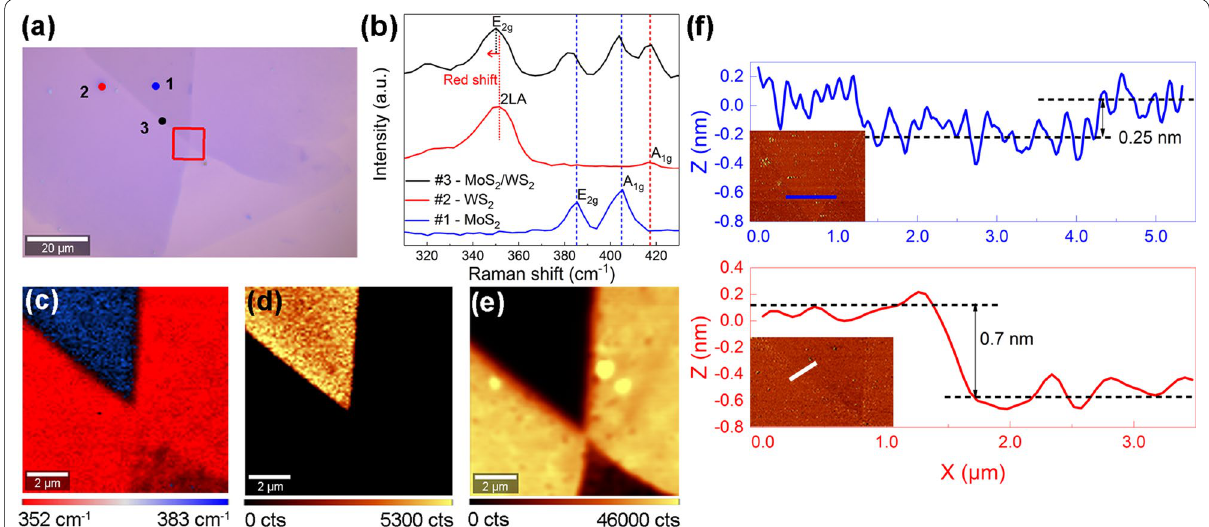
Fig. 1 Material characterization results of the as-grown lateral monolayer MoS 2 /WS 2 heterostructure. ( a) The optical image of the lateral monolayer MoS 2 /WS 2 heterojunction. ( b) The Raman spectrum obtained from the site marked with 1, 2 and 3 in ( a ), respectively. The Raman mapping image ( c ), PL mapping images of MoS 2 region ( d ) and WS 2 region ( e ) from the red framed area in ( a ). The corresponding false-color bar is inserted at the bottom of ( c )–( e ). ( f ) The corresponding cross-sectional height profile of the blue (between WS 2 and MoS 2 ) and white (between WS 2 and substrate) lines marked in AFM morphology